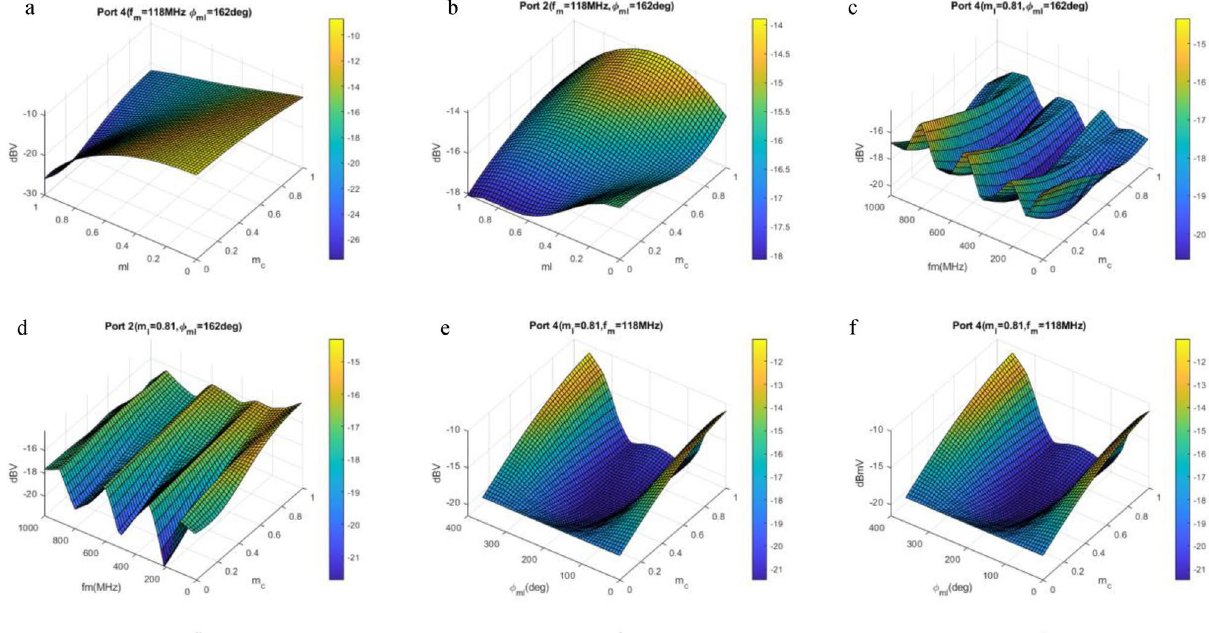
Figure 7. Parametric study of crosstalk versus different parameters, investigating effect of capacitive modulation index and, ( a ) inductive modulation index in port 4, ( b ) inductive modulation index in port 2, ( c ) modulation frequency in port 4, ( d ) modulation frequency in port 2, ( e ) inductive modulation phase in port 4 and ( f ) inductive modulation phase in port 2. Signal in port 4 represents the far-end crosstalk and port 2 the main line